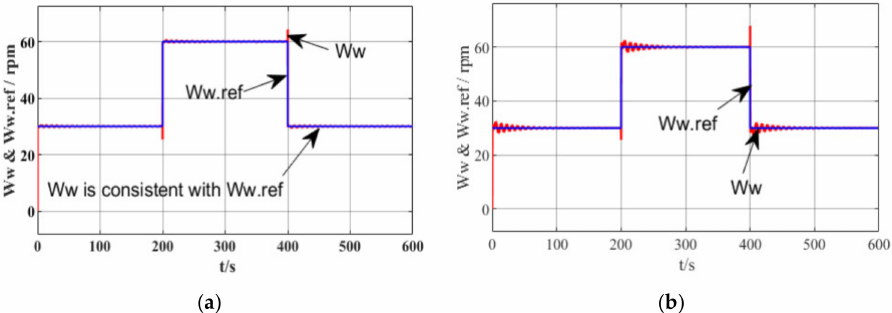
Figure 16. While α alter, the wind turbine speed waveform of PID control based on IMC and experiment scheme 1. ( a ) The speed waveform of α = 10; ( b ) The speed waveform of α = 2.